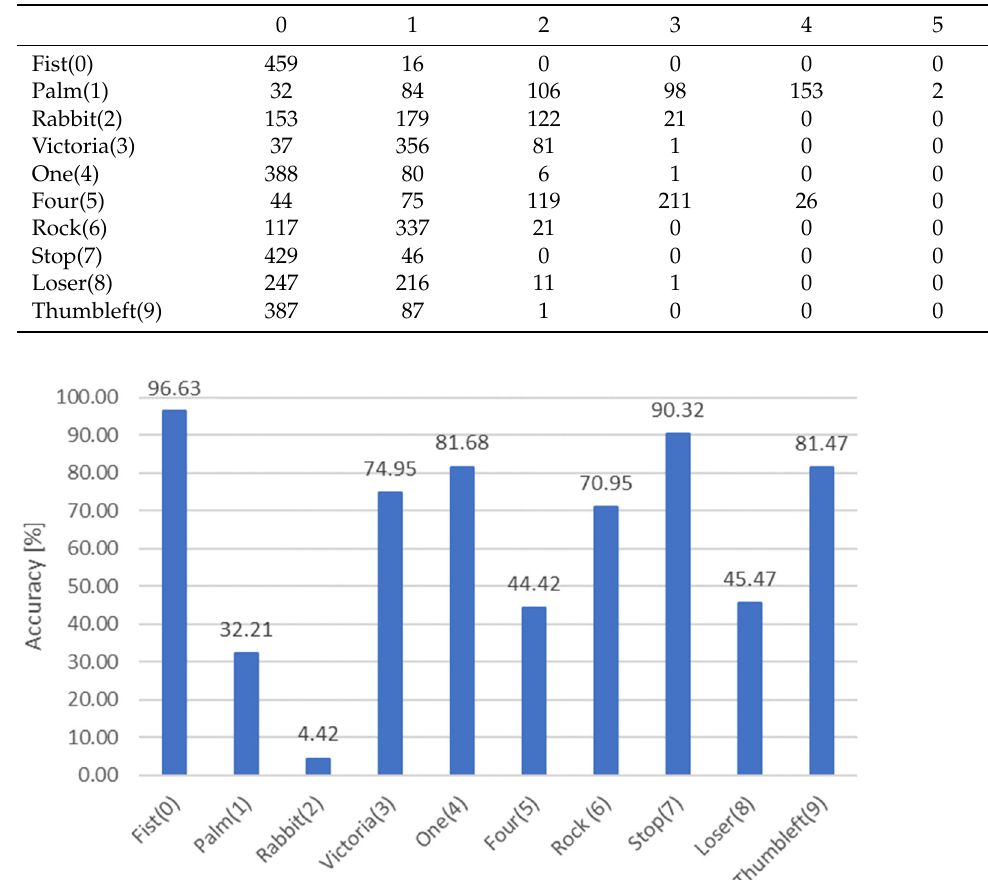
Table 1. Number of detected convexity defects for gestures 0–9.